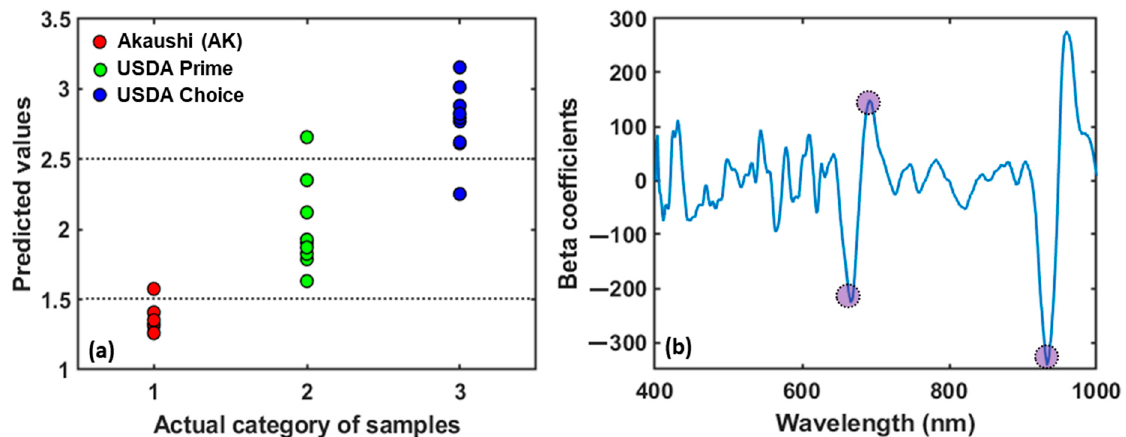
Figure 4. ( a ) Classification results of the 3 beef grade samples based on the thresholds of <1.5 = Akaushi, 1.5 to <2.5 = USDA prime, and 2.5 and greater = USDA choice; red = Akaushi, green = USDA prime, blue = USDA choice. ( b ) Beta coefficient curve derived from the PLS-DA model using Savitzky–Golay second derivatives pre-processing methodology. Significant wavelengths for distinguishing different beef grades are marked with violet circles.